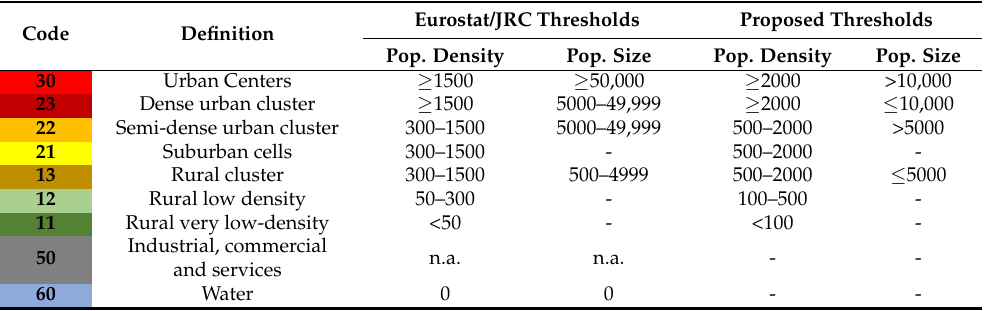
Table 1. Classes defined by Eurostat/JRC for the classification of settlements and their adaptation to the Italian context. For the “Water” class, there must be no population and at least half a pixel must be covered with water. The revision of the thresholds takes into account the differences between the GHS-POP data (to which the Eurostat/JRC thresholds refer) and the proposed data, in terms of spatial resolution and a different criterion for the spatialization of the